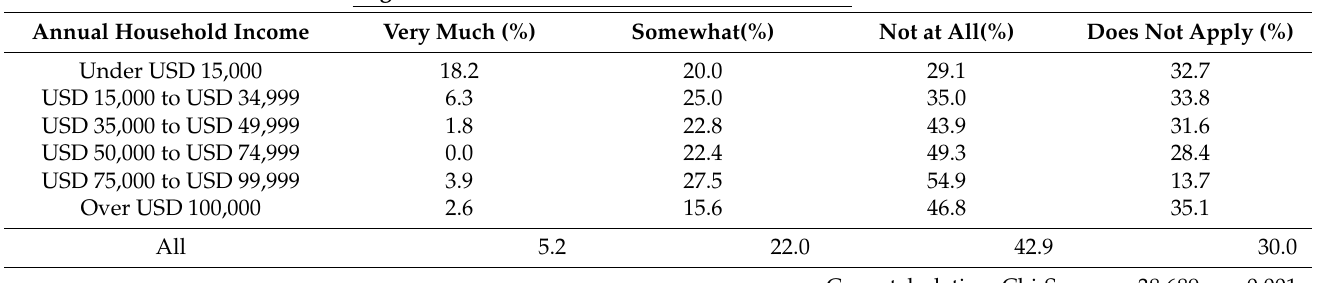
Cross-tabulation, Chi-Square = 38.689, p = 0.001 Source: EIWA Survey, fall